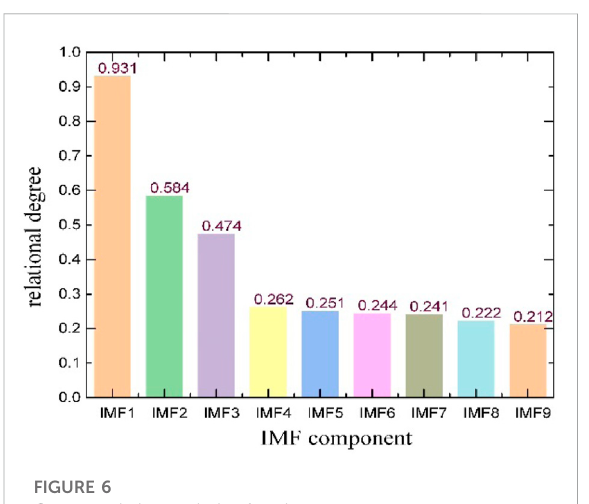
FIGURE 6 Grey correlation analysis of each component. FIGURE 7